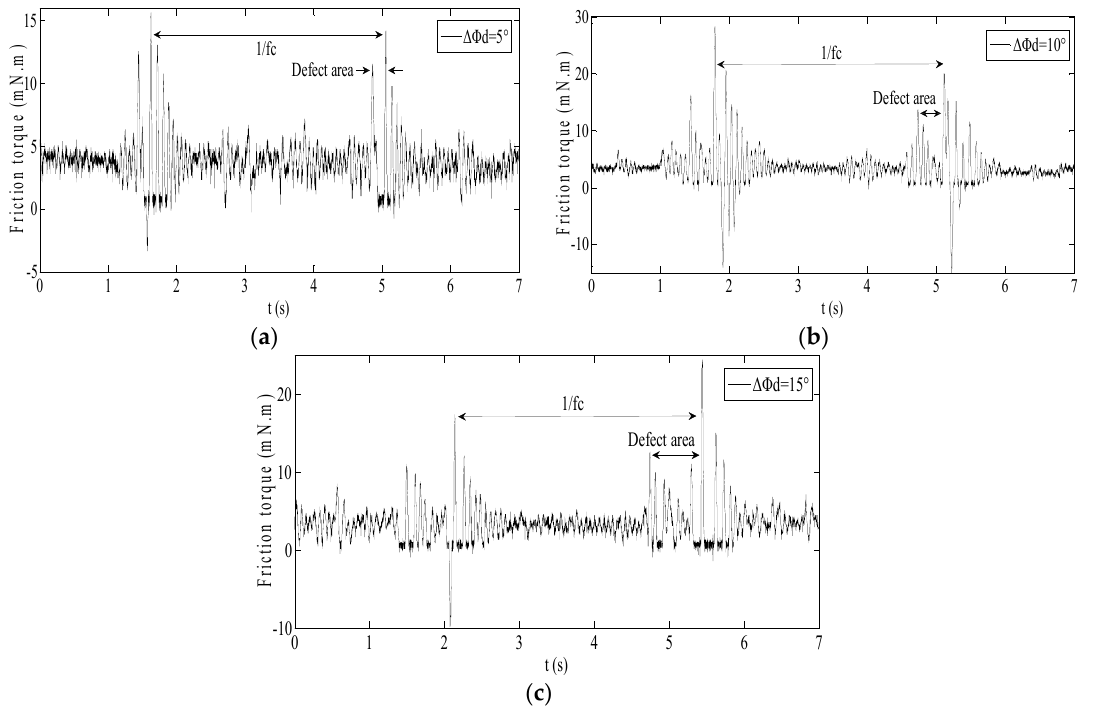
Figure 11. Friction torque of bearing with different spall length: ( a ) Δ Φ d = 5°; ( b ) Δ Φ d = 10°; ( c ) Δ Φ d = 15°.